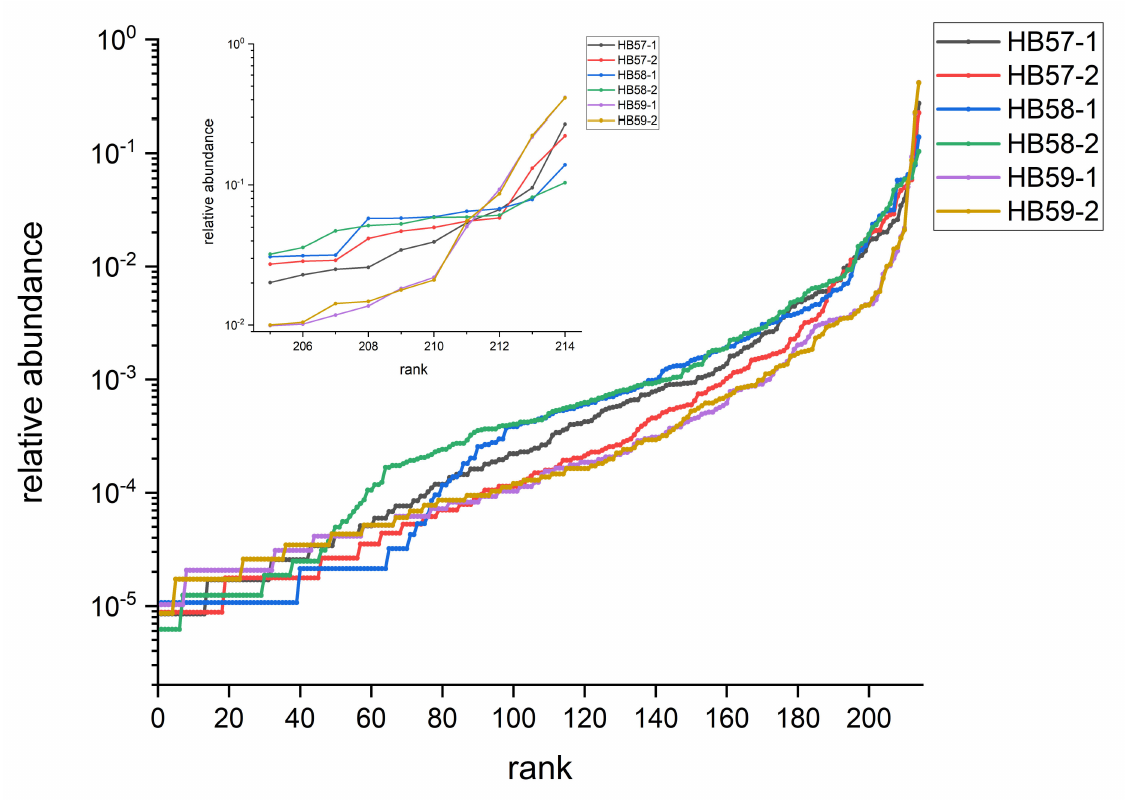
Figure 3. Normalized rank plots (inset: normalized frequencies of the top ten OTUs for each sample). The y-axis is a logarithmic scale. It shows the relative frequency (y-axis) of the ranked OTUs from low read counts (lower rank, x-axis) to high read counts (upper rank, x-axis). Therefore, the rank around 230 represents the most frequent OTU from the NGS analysis. However, for each sample, this may mean a different